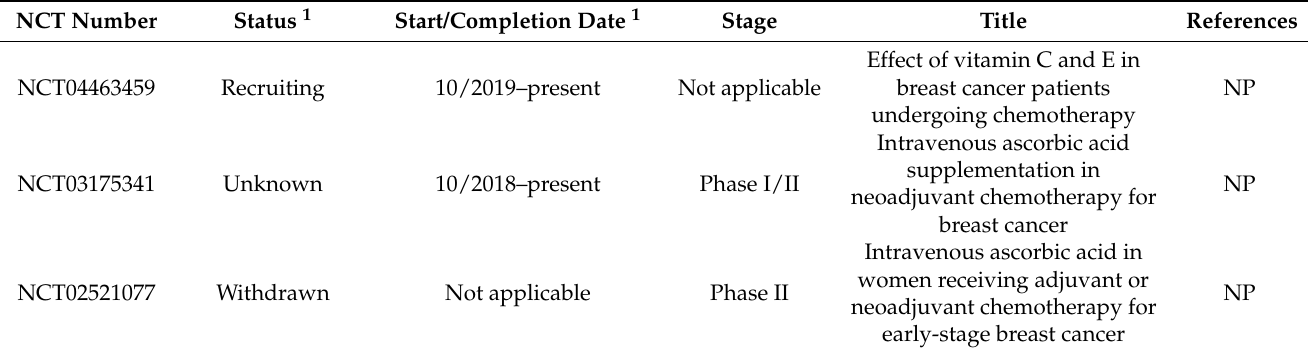
Table 5. Clinical trials with vitamin C in breast